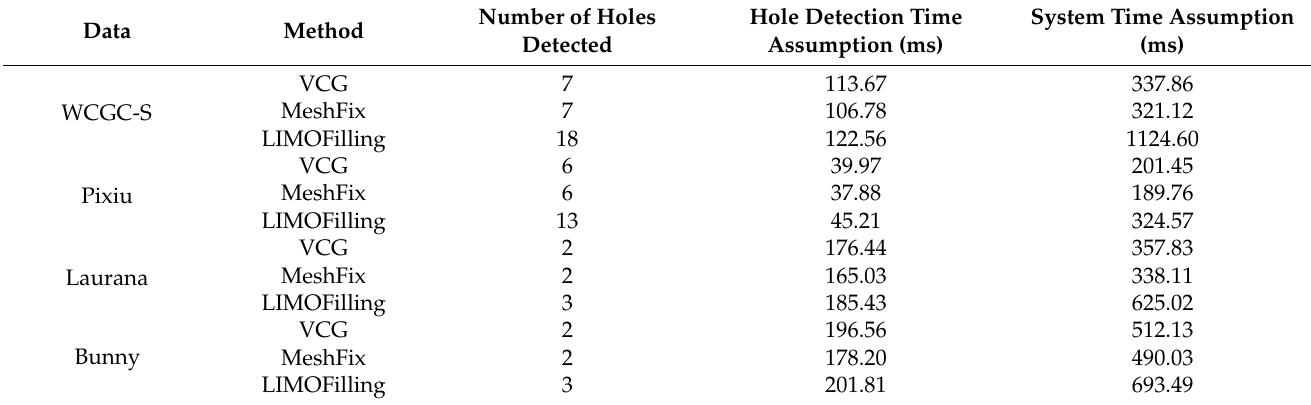
Table 1. Number of holes detected and system efficiency comparisons between different methods.